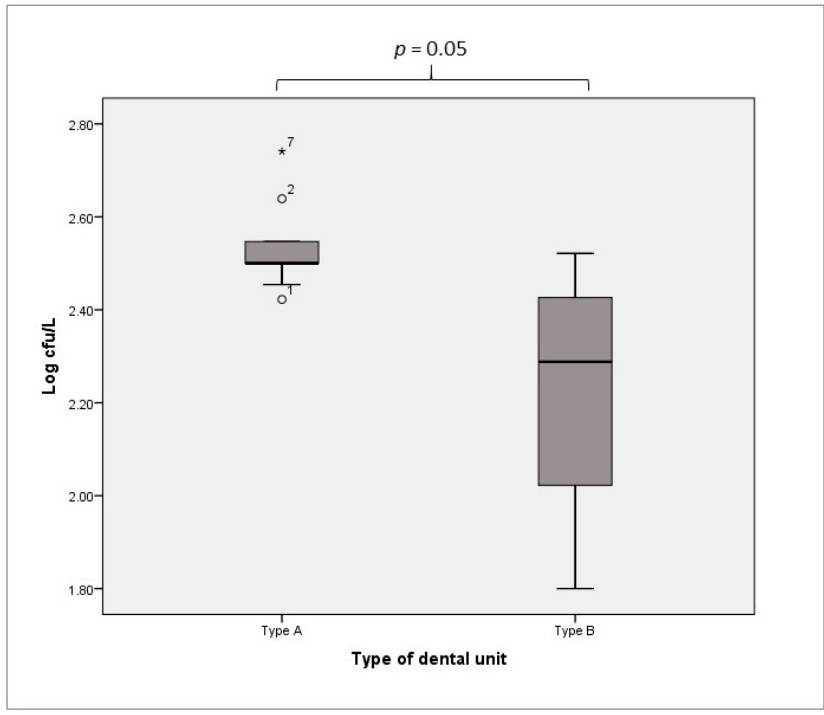
Figure 3. Legionella spp. contamination of Type A vs. Type B DUWLs.